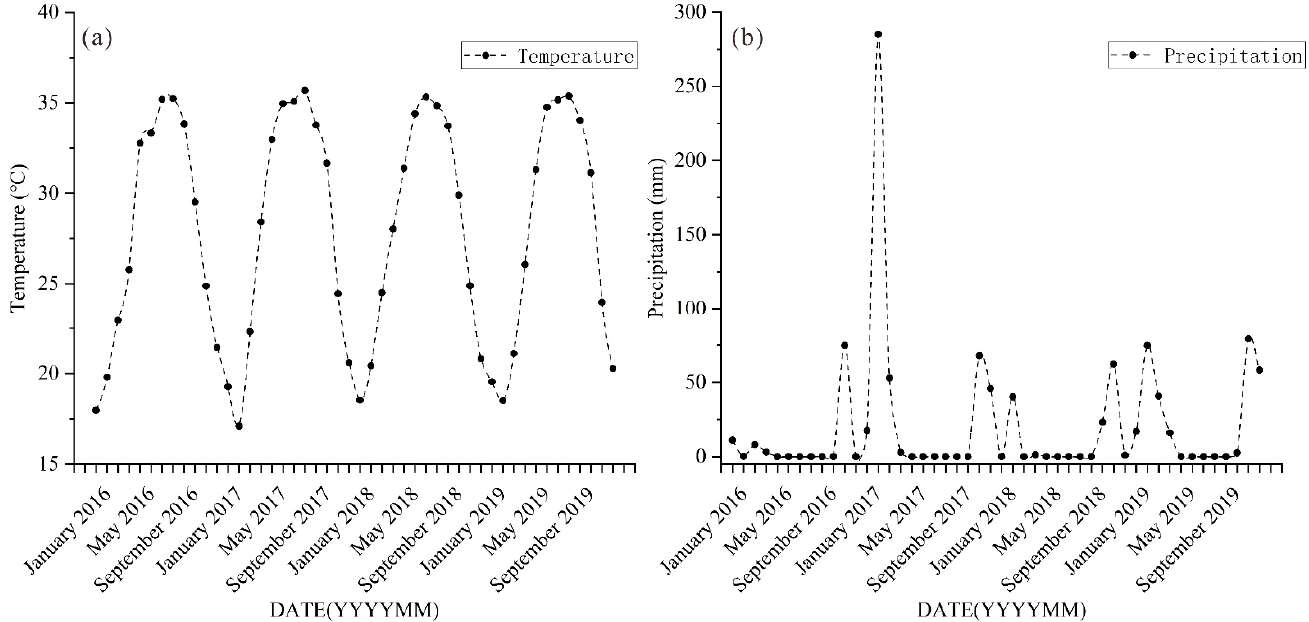
Figure 3. ( a ) Monthly temperature data from January 2016 to October 2020 recorded by BANDAR-E DAYYER weather station; ( b ) Monthly precipitation data from January 2016 to October 2020 recorded by BANDAR-E DAYYER weather